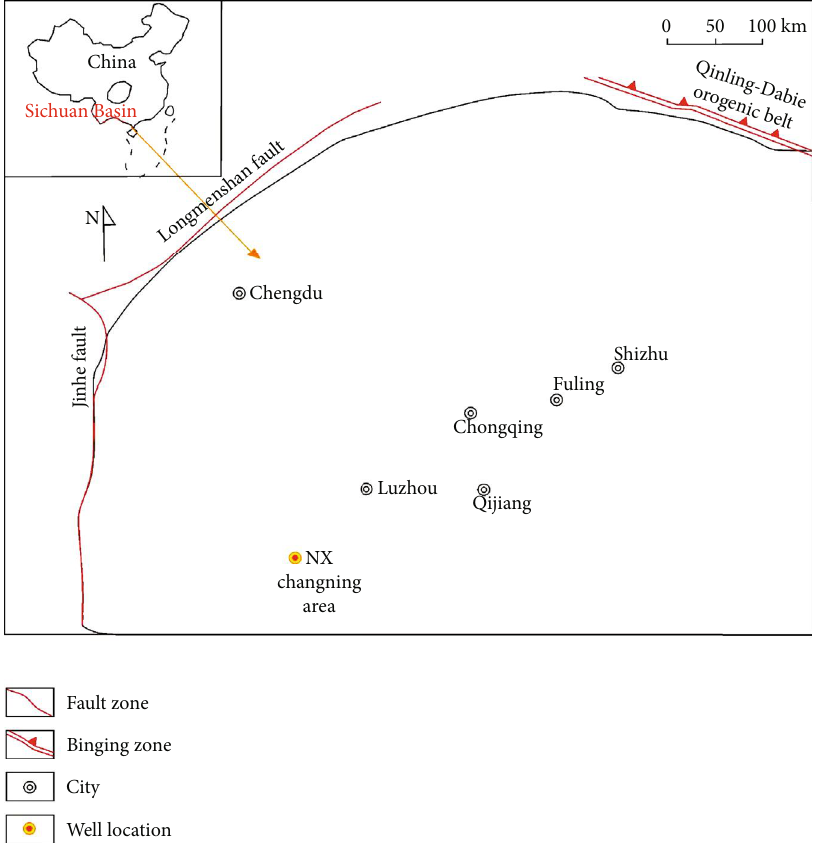
Figure 1: Geological background and core location (well NX is marked as a colored dot in Changning area) in Sichuan Basin in the southwest of China. Sichuan Basin is surrounded by the orogenic belt around Longmen Mountain, Jinhe Mountain, and Qinling Mountain. The study region is located in the southwest region of Sichuan